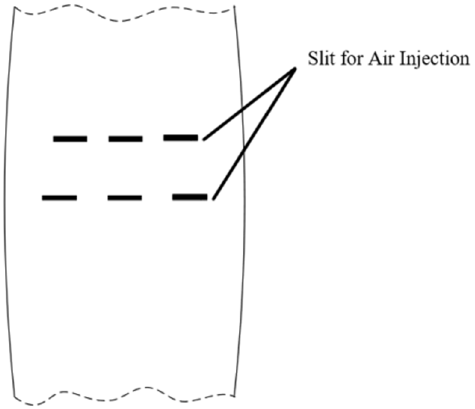
Figure 9. Arrangement of air injection units.